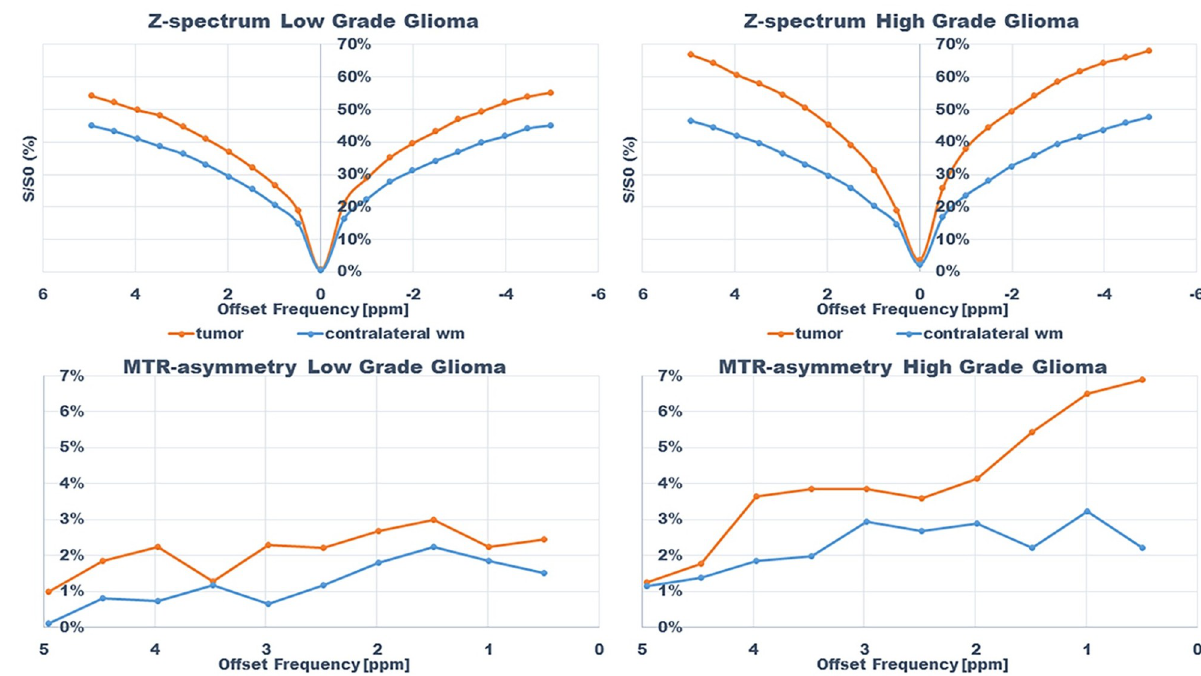
Fig 8. Z-spectra and magnetization transfer ratio asymmetry spectra for subjects; subject 13 (HGG) and 9 (LGG) within tumor and in contralateral normal appearing white matter.